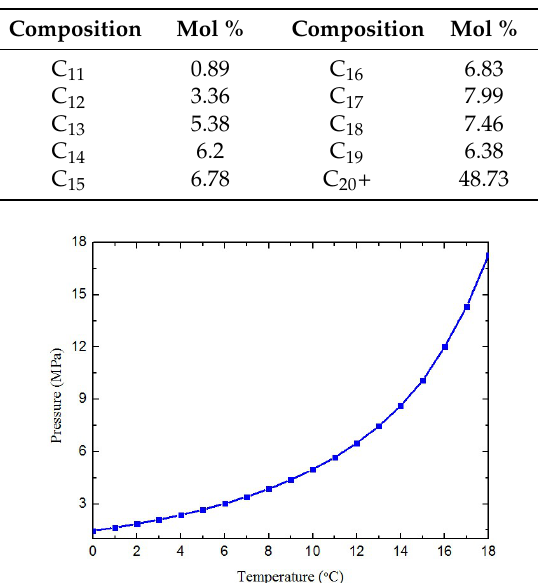
Figure 2. Hydrate formation curve of the testing natural gas.